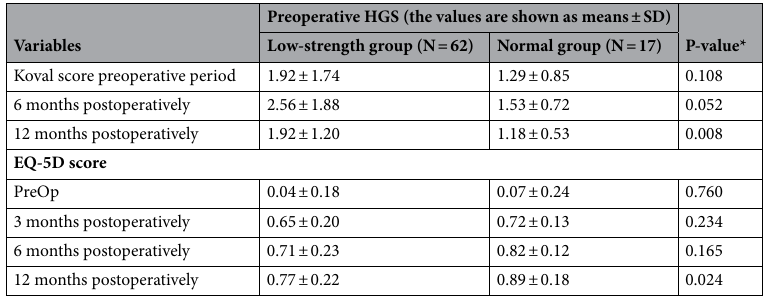
Table 4. Comparison of functional outcomes between the “low strength” group and “normal” group using preoperative HGS (the values are shown as mean ± SD). EQ-5D European Quality of Life Five Dimension, HGS handgrip strength. *Mann–Whitney U test.